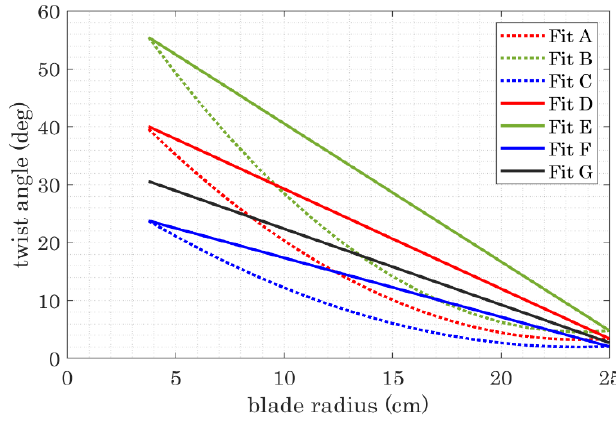
Figure 2. SSWT CAD designs with ( a , c ) linear and ( b , d ) nonlinear twist distributions for the NACA4412 airfoil, with x-z view ( top ) and y-x view ( bottom ).